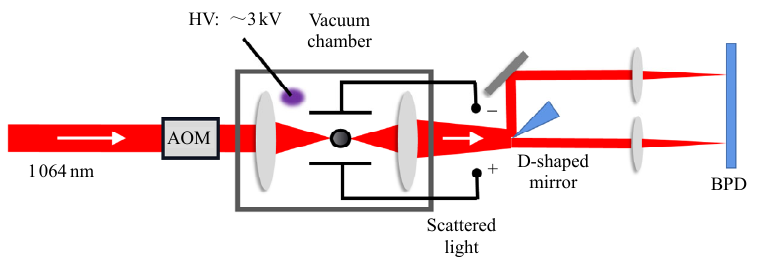
Fig. 3 Schematic diagram of the experimental